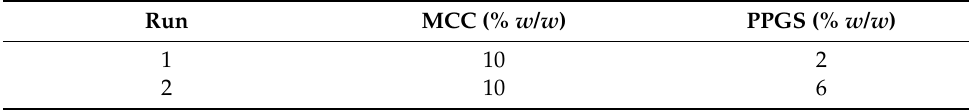
Table 2. A 3 2 full-factorial experimental